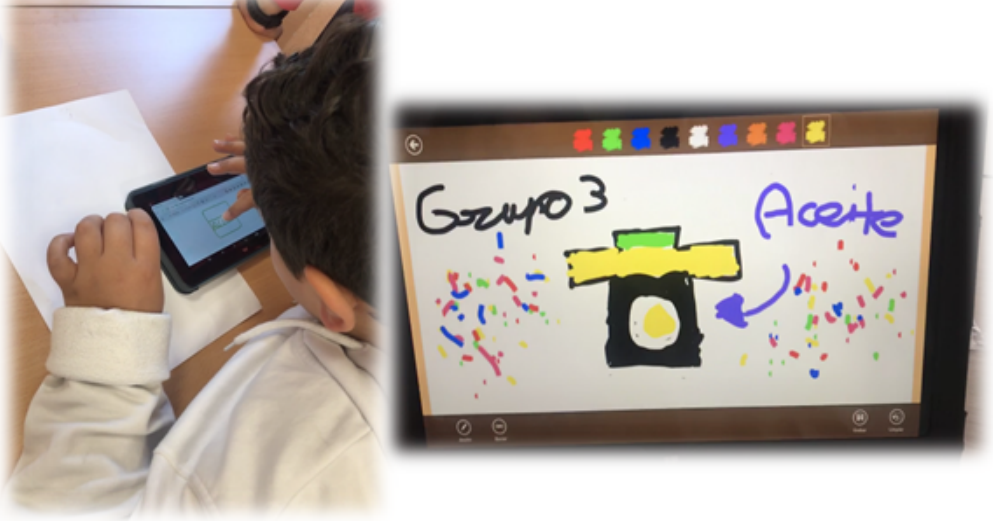
Figure 3. A child’s drawing of a container for collecting used cooking oil.